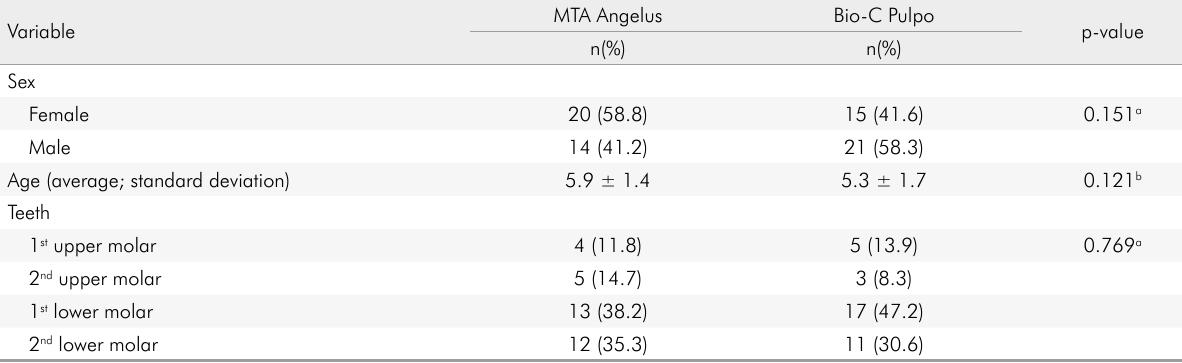
Table 2. Patient characteristics and tooth distribution at baseline Variable